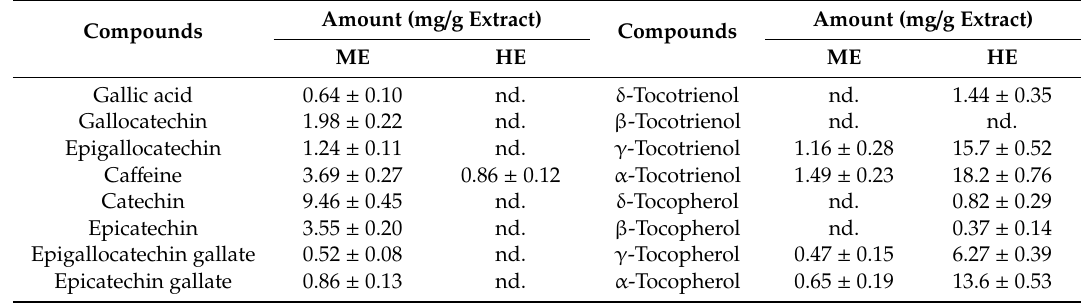
Figure 3. HPLC chromatograms of hexane extract of ( A ) hexane extract of C. japonica seed coats and ( B ) mixed tocotrienols and tocopherols standards. The peaks are ( a ): δ -tocotrienol; ( b ): β -tocotrienol; ( c ): γ -tocotrienol; ( d ): α -tocotrienol; ( e ): δ -tocopherol; ( f ): β -tocopherol; ( g ): γ -tocopherol; and ( h ): α -tocopherol. Table 3. The amount of phytochemical compounds in the ME and HE extracts. All values are expressed as mean ± standard deviation ( n = 3). nd: not